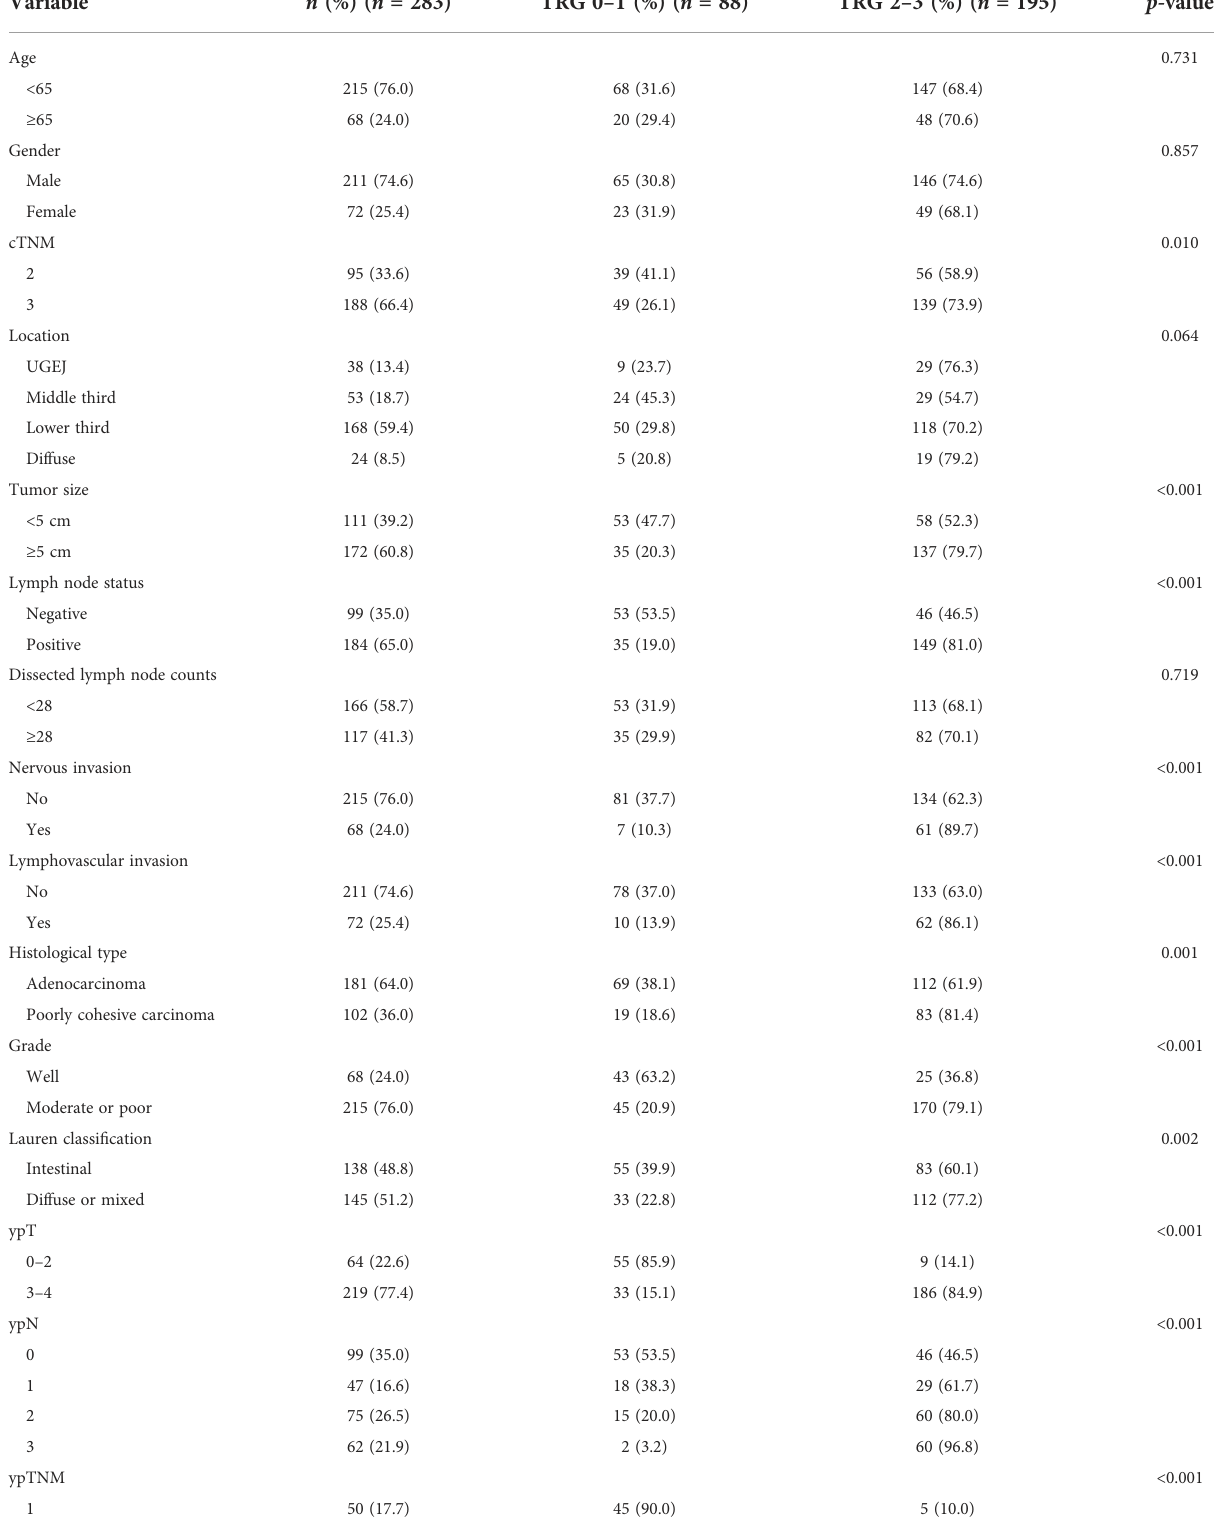
TABLE 1 Association of baseline characteristics to